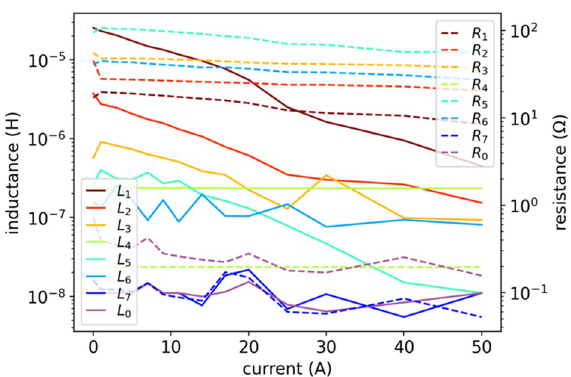
Figure 4. NLS results of inductances L ( i ) and resistances R ( i ) in model (3). Here we do not enforce monotonic inductance using Langevin derivative and constant